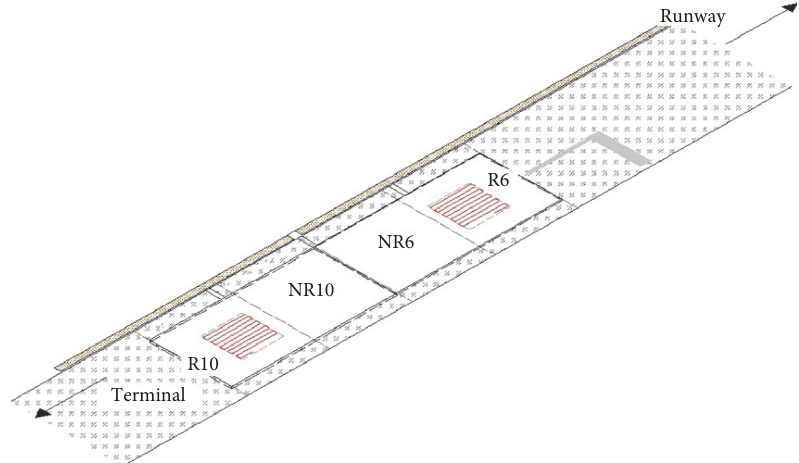
Figure 2: Scheme of installation in the trial